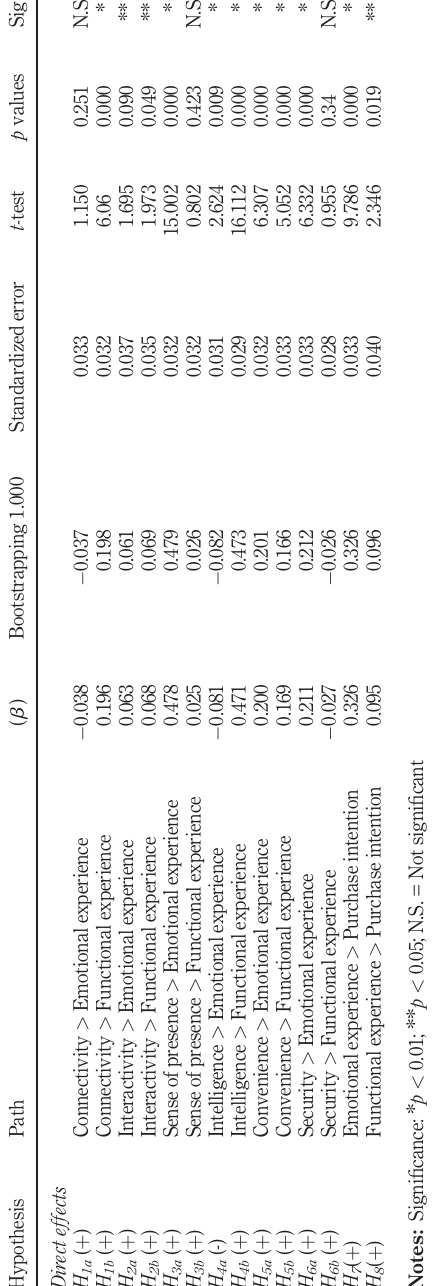
Table V. Analysis of path